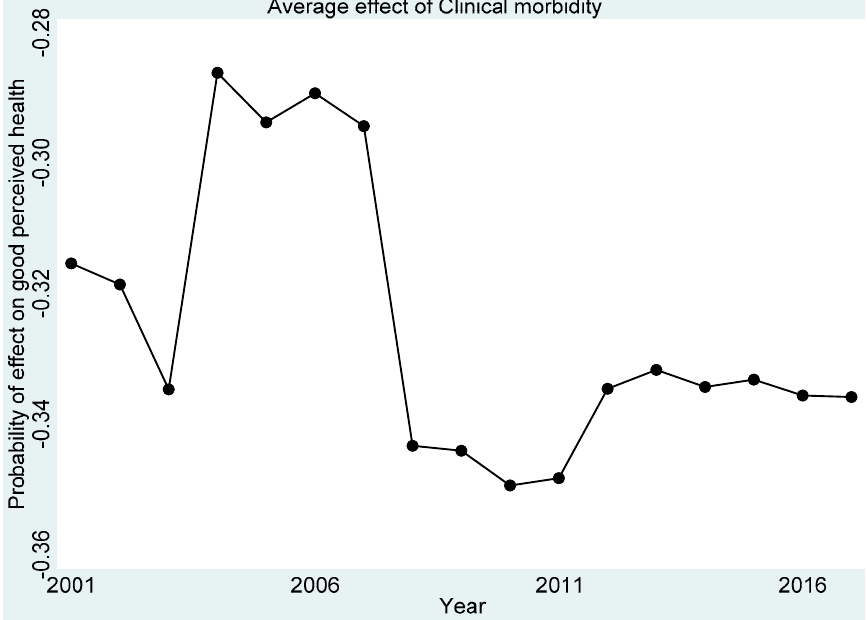
Figure 4. Probability of effects on “good” perceived health from the average effect of clinical mor- bidity.